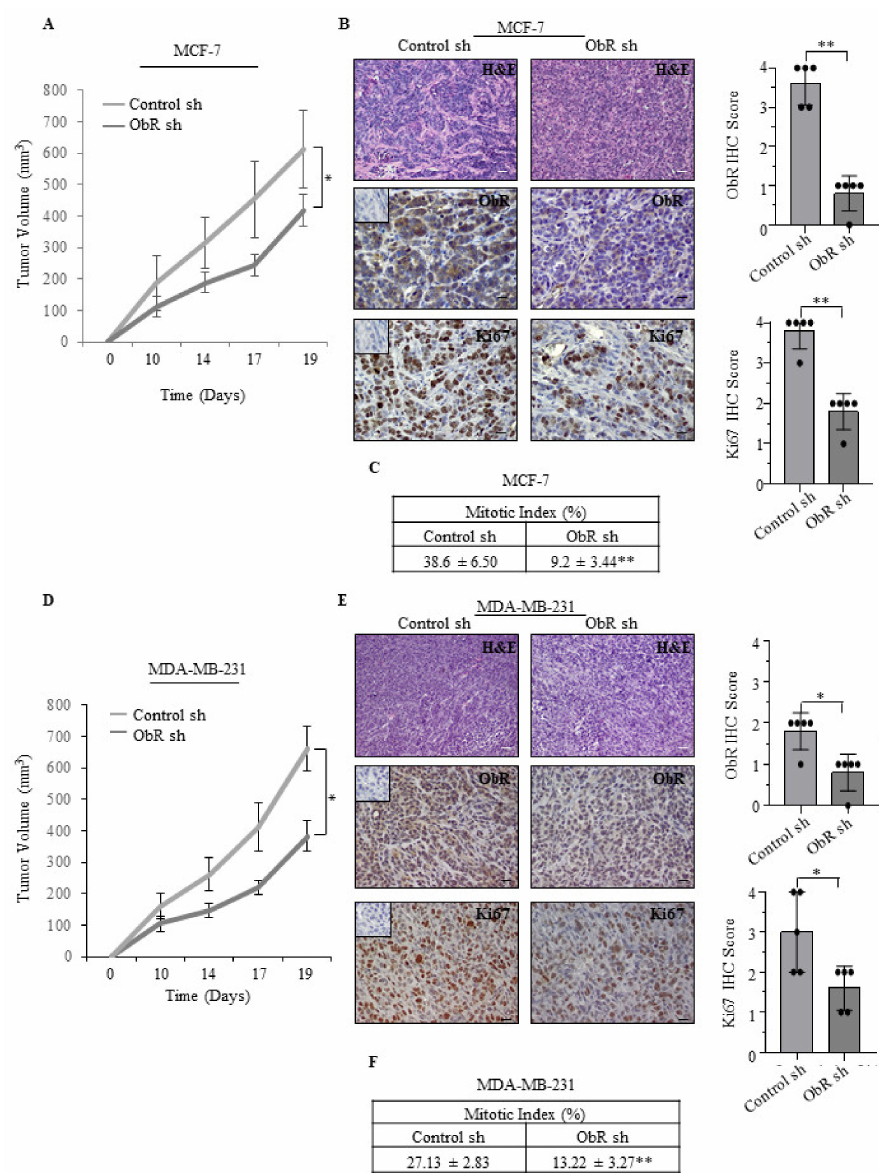
Figure 3. Impact of ObR ablation on tumor growth of MCF-7 and MDA-MB-231 xenografts. ( A , D ) Control sh and ObR sh MCF-7 and MDA-MB-231 breast cancer cells were orthotopically injected into nude mice (5 mice / each group). Tumor volume mean ± SD is shown. ( B , E ) Representative images of hematoxylin and eosin (H&E), leptin receptor (ObR) and Ki-67 immunohistochemical staining and relative score of Control sh and ObR sh MCF-7 and MDA-MB-231 xenograft tumor sections. Inset, negative control. Scale bar: white = 50 µ m, black = 25 µ m. ( C , F ) Mitotic index in the Control sh and ObR sh MCF-7 and MDA-MB-231 xenograft tumor sections. Values are expressed as mean ± SD. * p < 0.05, ** p <